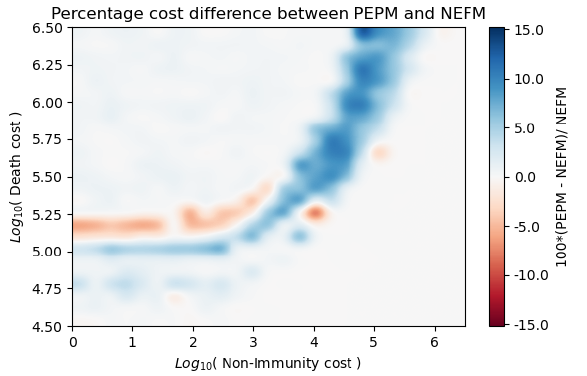
Figure 7. Heatmap showing percentage difference in total cost between final solutions obtained by PEPM and NEFM, as a function of death and non-immunity